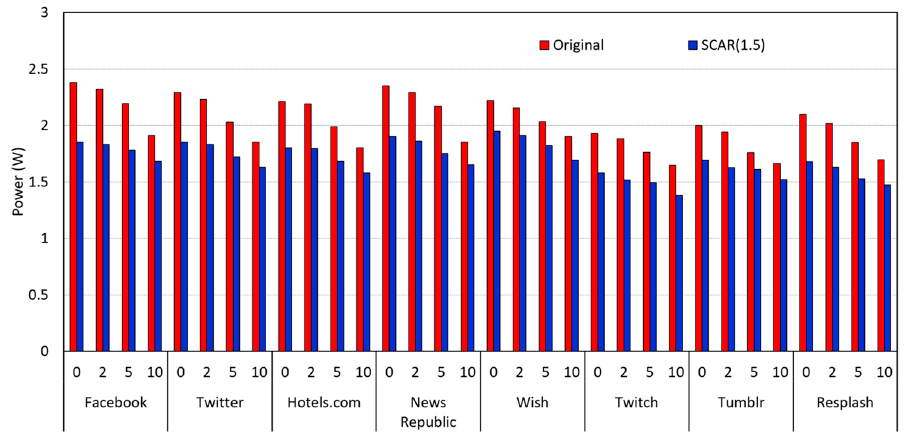
Figure 20. Power consumption for various apps in realistic smartphone usage scenarios considering a realistic device setting and reading time intervals.